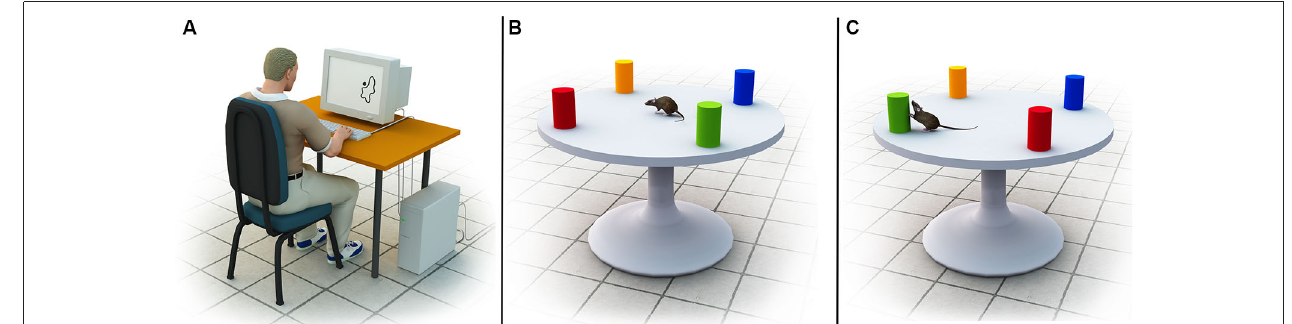
(2005). Shown is the geometric configuration of colored objects on top of a round board. (C) After rats habituated to the environment, either a categorical or coordinate transformation was applied (in this illustration, a categorical transformation via a left-right transposition of the green and red landmarks is shown). Subsequent assessment of the rats’ re-exploration behavior served as an indicator of the precision of their internal representation of the